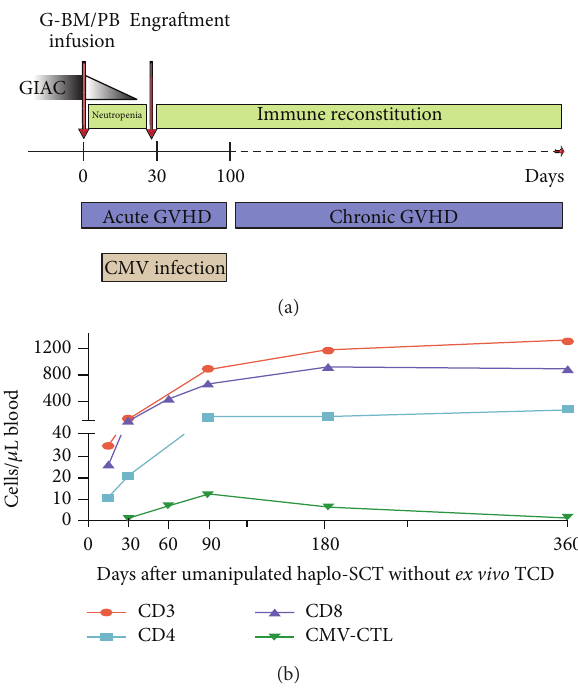
Figure 1: T cell immune reconstitution and CMV infection fol- lowing unmanipulated haplo-SCT without ex vivo TCD (GIAC transplant protocol, Peking University Institute of Hematology). CMV, cytomegalovirus; GVHD, graft-versus-host disease; CMV- CTL, CMV-specific CTL; TCD, T cell depleted; G-BM/PB, combin- ing G-CSF-primed bone marrow (G-BM) and peripheral blood (G- PB)